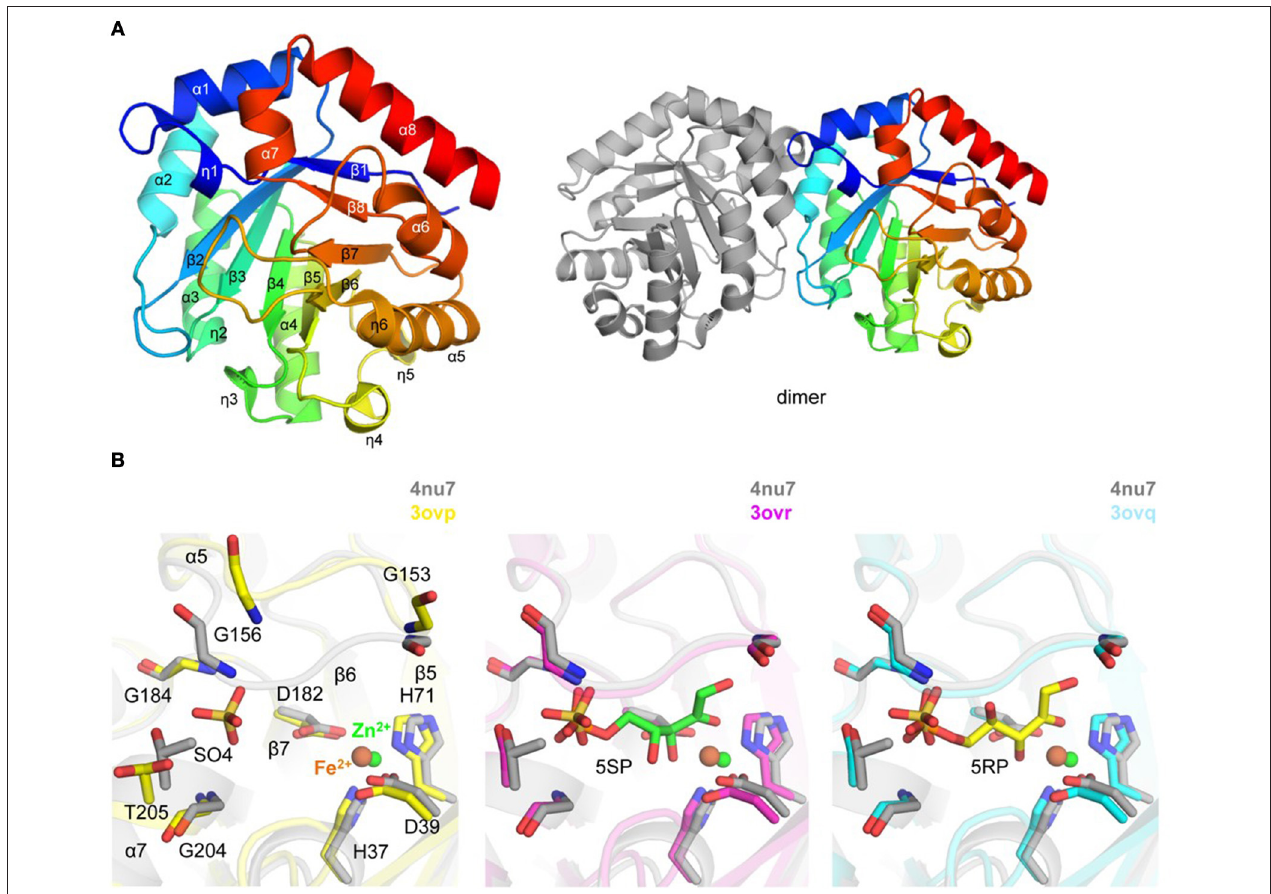
FIGURE 4 | Crystal structure of Tg RPE (A) . Ribbon representation of Tg RPE monomer (left side) colored blue (N-terminus) to red (C-terminus) and Tg RPE dimer (right side) (B) . Pairwise structural alignment of Tg RPE (gray; SO4 is shown in sticks and Zn 2 + as green sphere) and human RPE with bound Fe 2 + (yellow ribbon), 5-O-phosphono-D-xylulose (5SR; magenta ribbon), and ribulose-5-phosphate (5RP; cyan ribbon) showing active site with residues of Tg RPE are shown in sticks and labeled in one-letter code. Equivalent residues of human RPE are